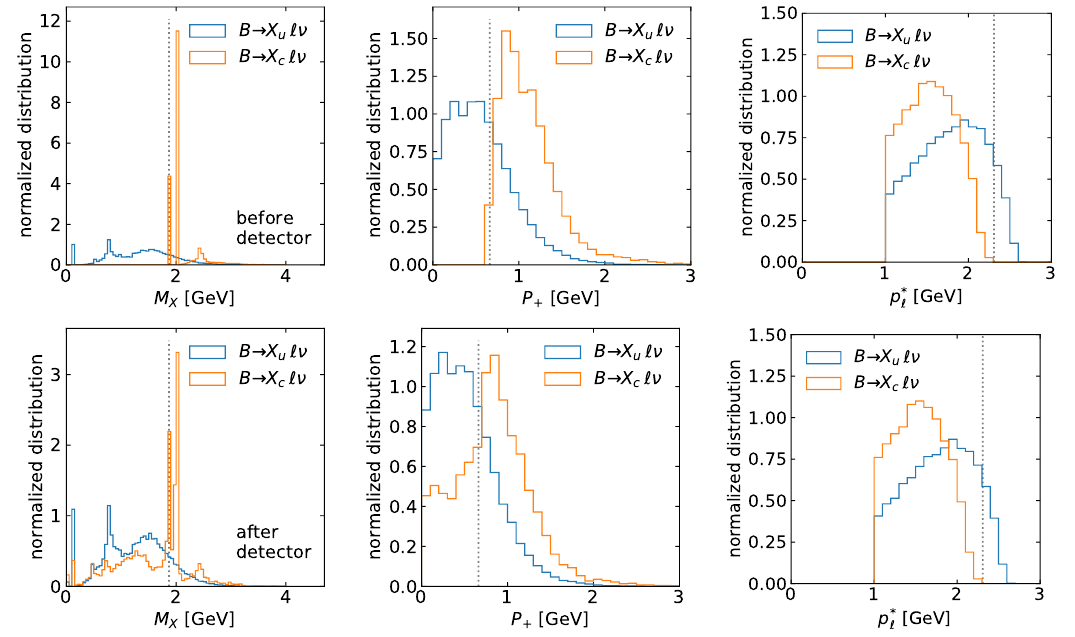
Figure 1 . E VT G EN hadronic mass distribution M X , energy-momentum difference P + and lepton momentum in B -meson rest frame p ∗ before (top) and after detector simulation (bottom). The gray ‘ lines highlight the boundaries of the theoretically background-free